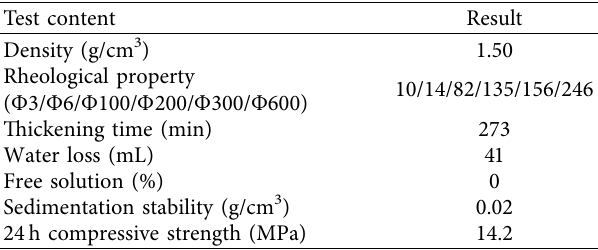
Table 11: Performance of the cement slurry system.